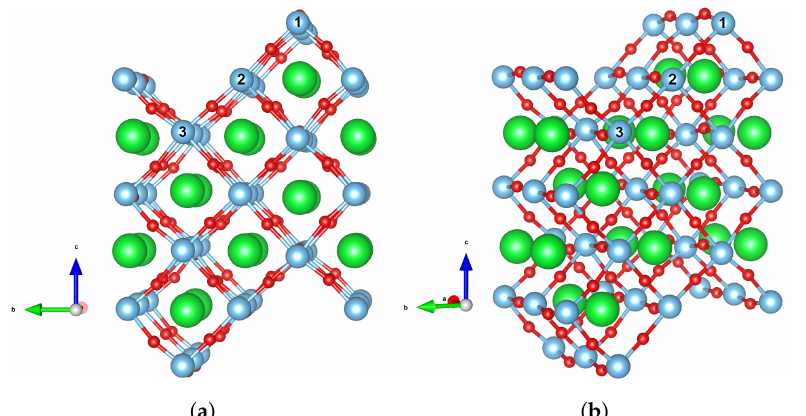
Figure 2. Stepped surface cell. The one-ridge adsorption area; two-slope adsorption area; and three-gully adsorption area. ( a ) Front view. ( b ) Isometric